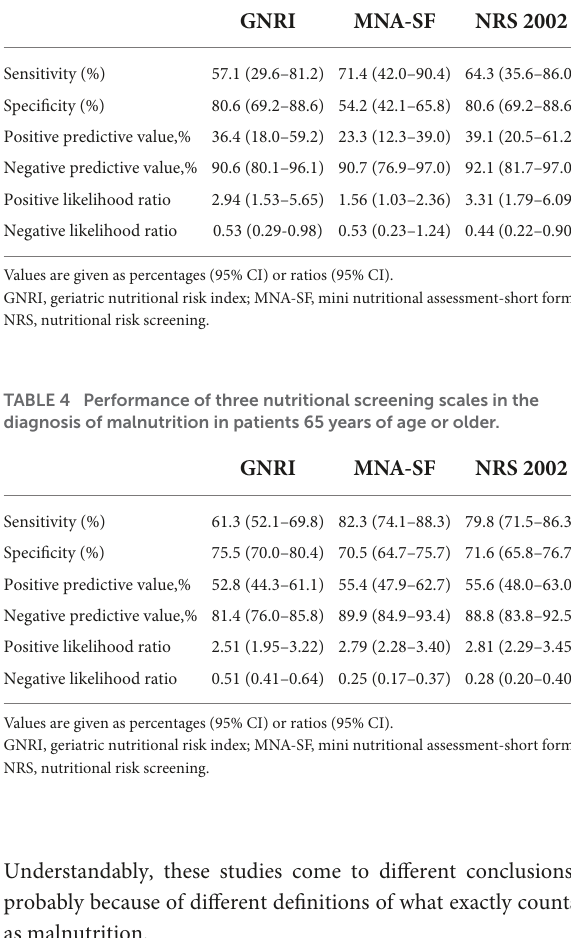
TABLE 3 Performance of three nutritional screening scales in the diagnosis of malnutrition in patients younger than 65 years old.